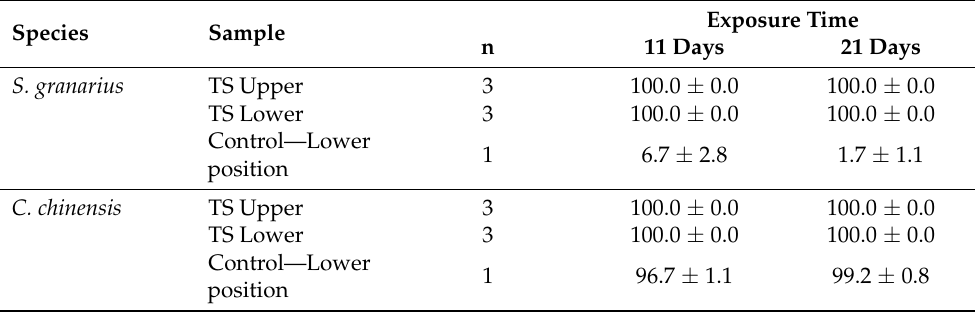
Table 6. Field efficacy (% of adult mortality; Av. % ± SE) of controlled nitrogens atmospheres (below 1% of oxygen) on adults of the tested species (S. granarius, C. chinensis ) in metal silos under two exposure regimes 11 (1 day N 2 purging; 10 days full N 2 concentration exposure) or 21 days. For each treated silo units (n = 3 silos) 4 bio-assay-dishes with insects were used.